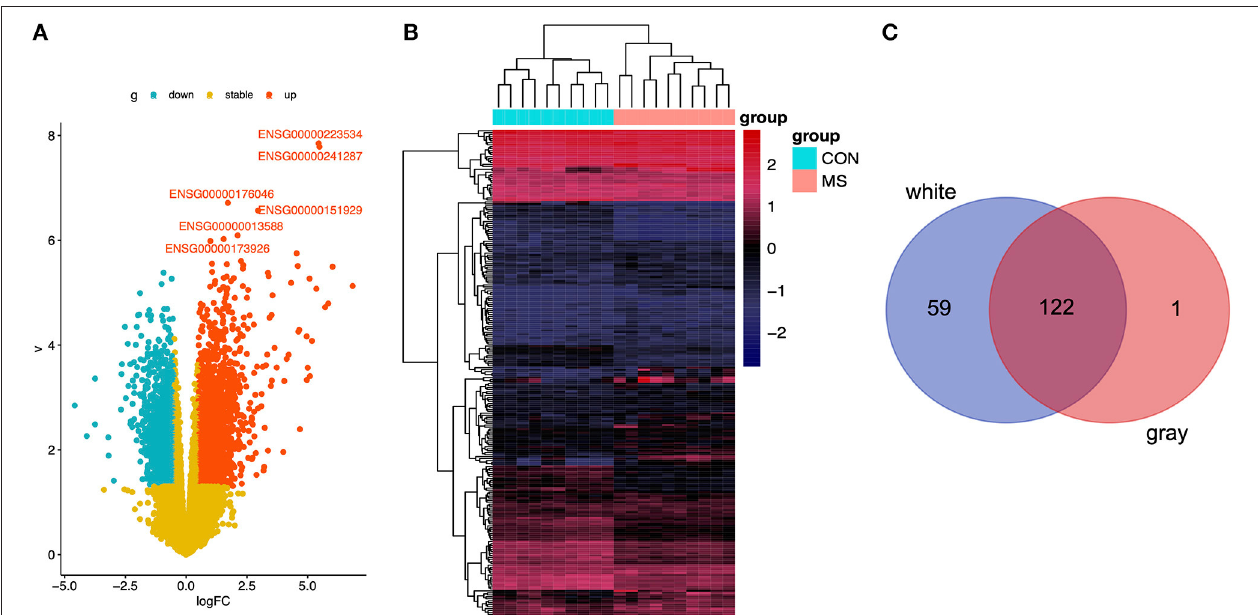
FIGURE 1 | (A) Volcano plot of DEGs in WM. (B) Heatmap of DEGs in WM. (C) Using the Venn tools to find the overlap genes between downregulated genes in DEGs and genes in black